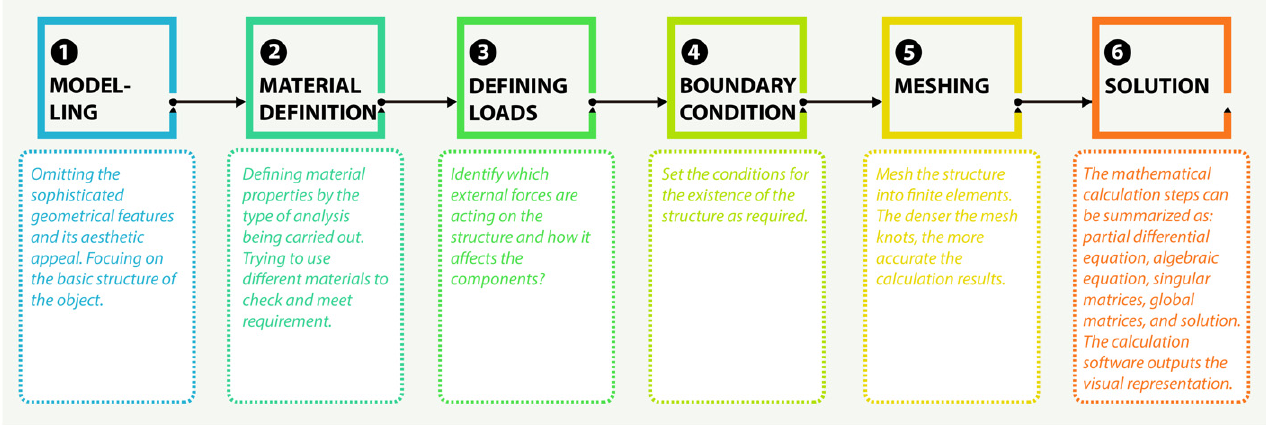
Figure 12. Basic steps of finite element analysis.